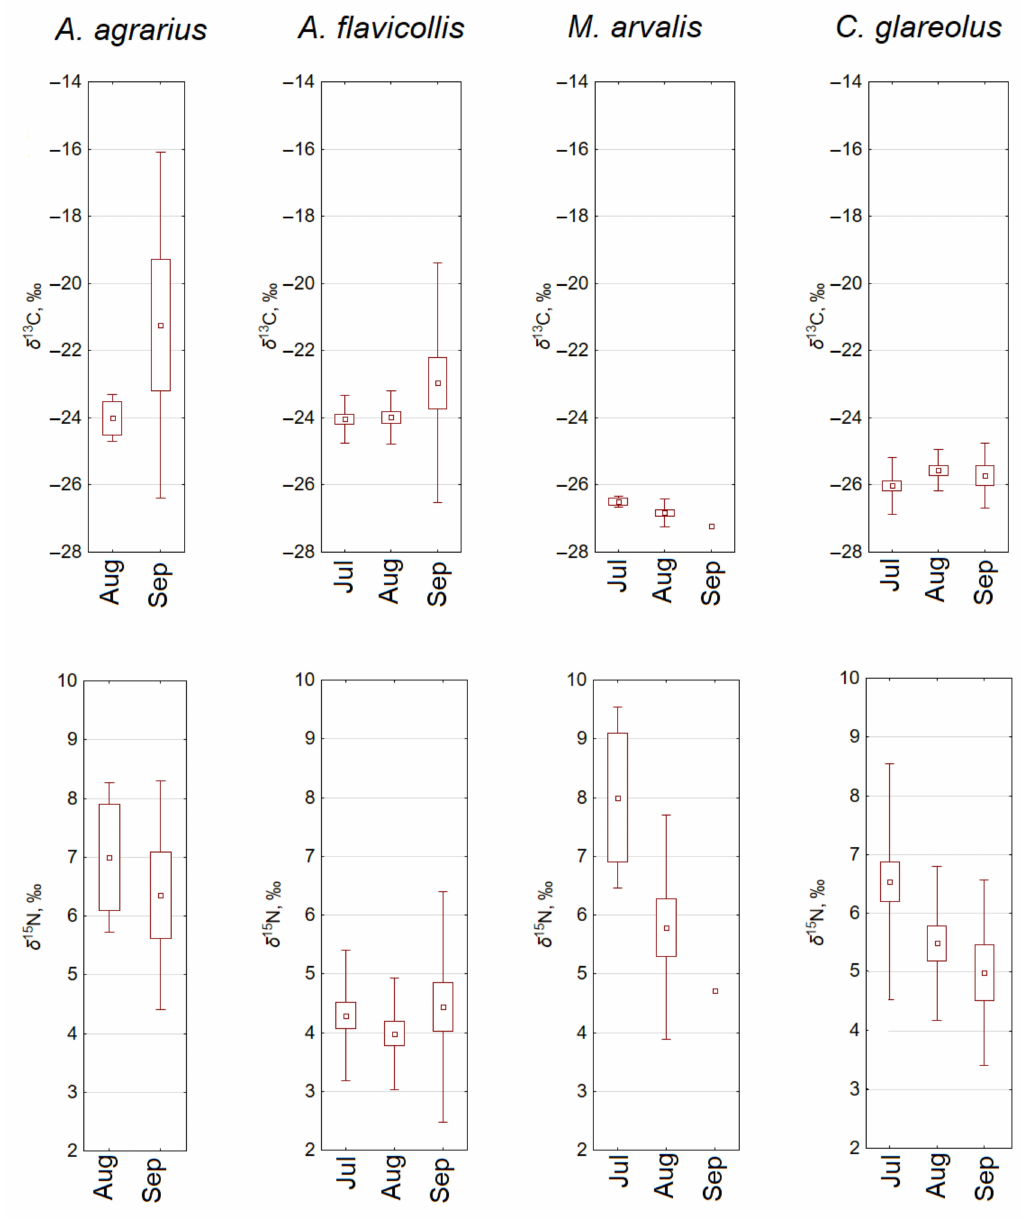
Figure 4. Temporal trend of stable δ 13 C and δ 15 N isotopes in small mammal hair (depending on the month of